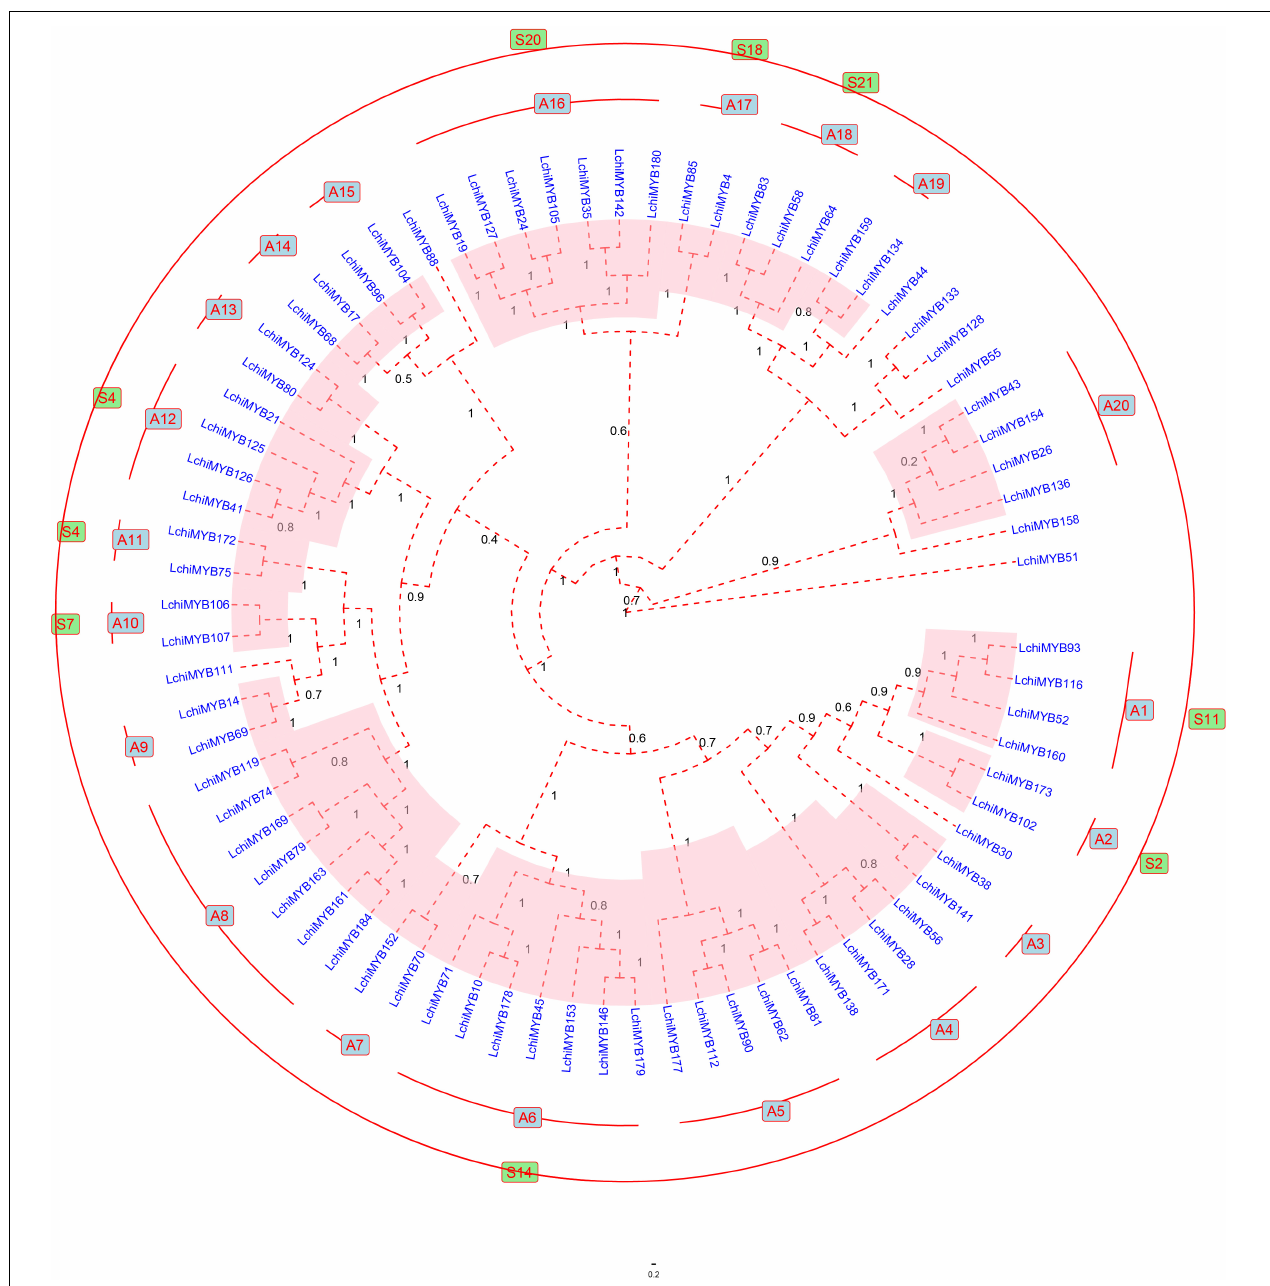
FIGURE 4 | The Bayesian tree showing the phylogenetic relationships between 76 Lchi R2R3-MYB proteins. The protein sequences are divided into 20 main groups, each marked with a subgroup number (e.g., A1). The groups homologous to Arabidopsis are labeled outside the evolutionary tree and are indicated by the color green. The bootstrap values are supported by 1,000 replications and are shown beside the branches. Only 11 proteins did not cluster into any group.